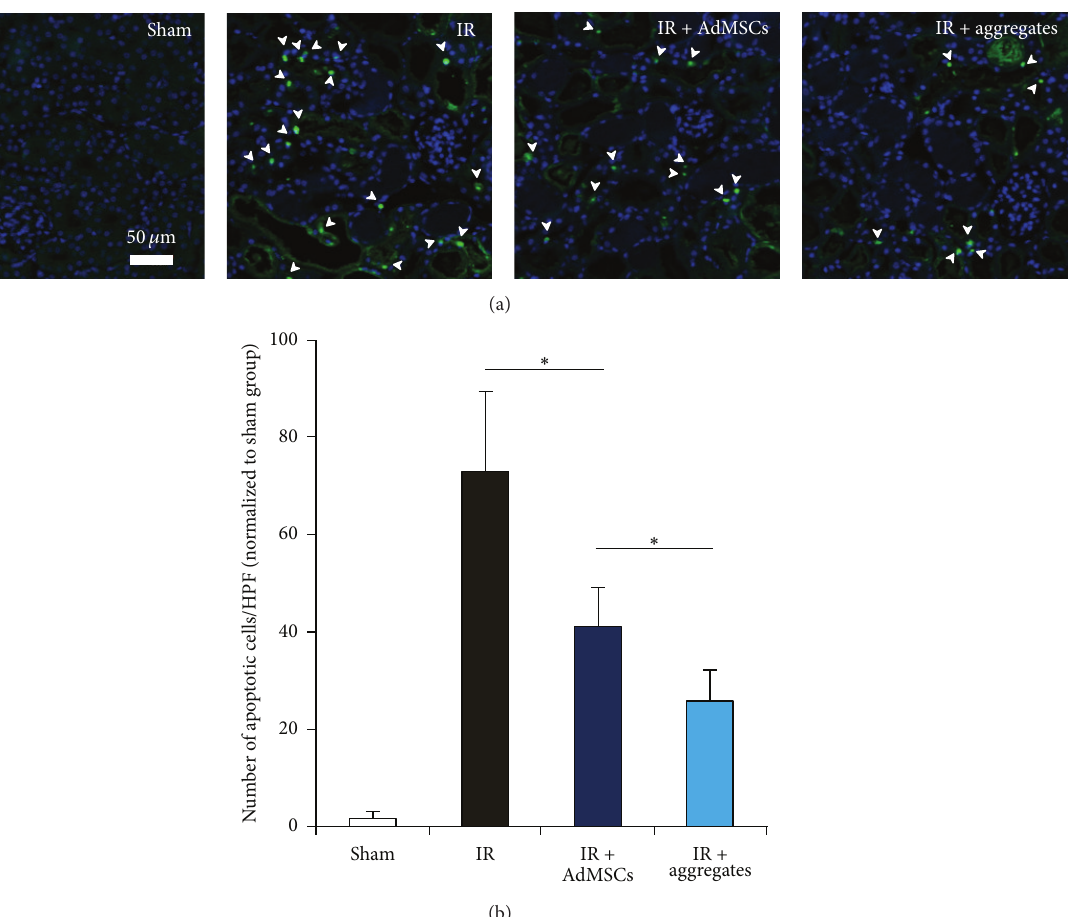
Figure 5: 2D AdMSCs or 3D aggregate reduces tubular apoptosis after IR. (a) Representative images of TUNEL staining of kidney sections in each experimental group. White arrow indicated apoptotic cells in tubules. (b) Results of the number of apoptotic cells in kidney sections in each group. ∗ 𝑃 < 0.05